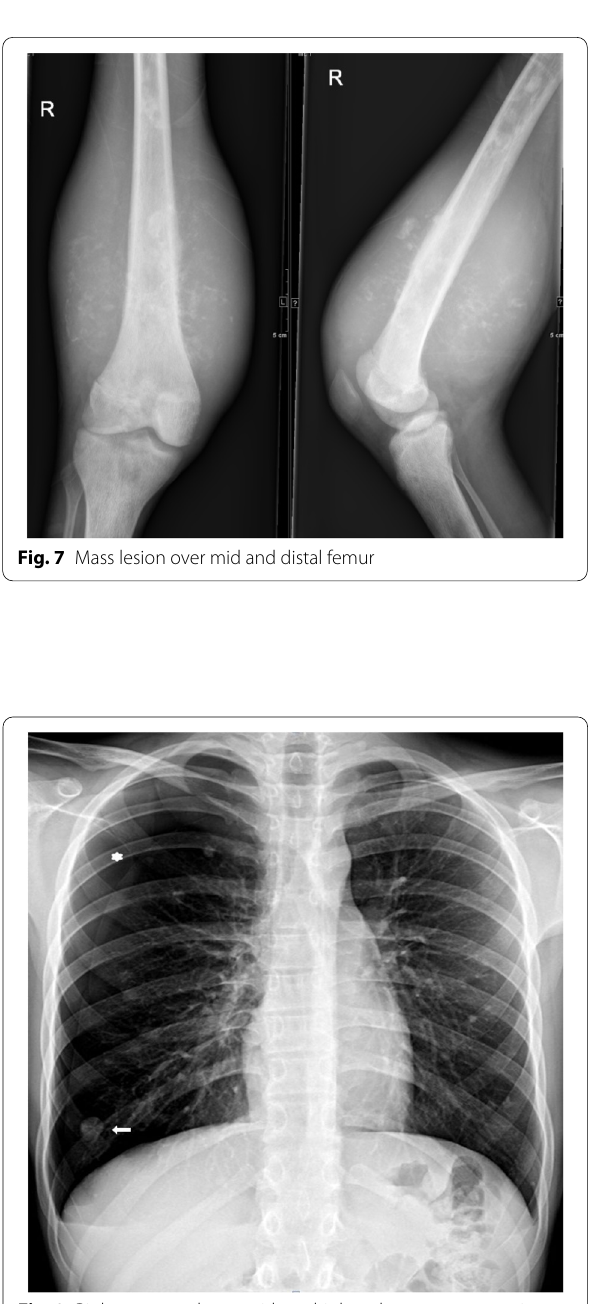
right hemithorax. Chest X-ray showed a right-sided pneumothorax (Fig. 8), and a 20-French ICD was inserted. Follow-up chest X-rays showed expanded lung but persisting Cerfolio grade 1 air leak. Hence,